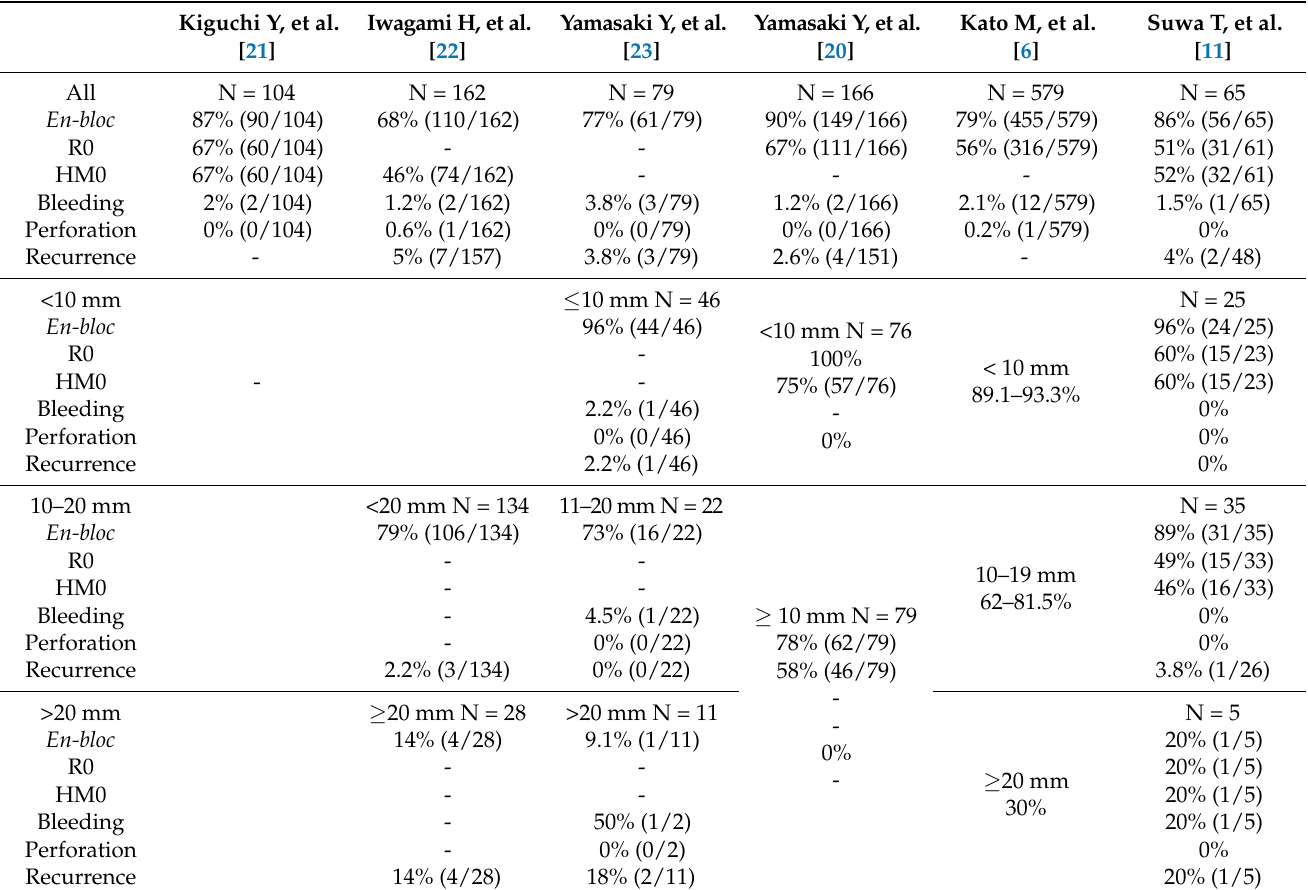
Table 3. Summary of UEMR treatment outcomes in previous